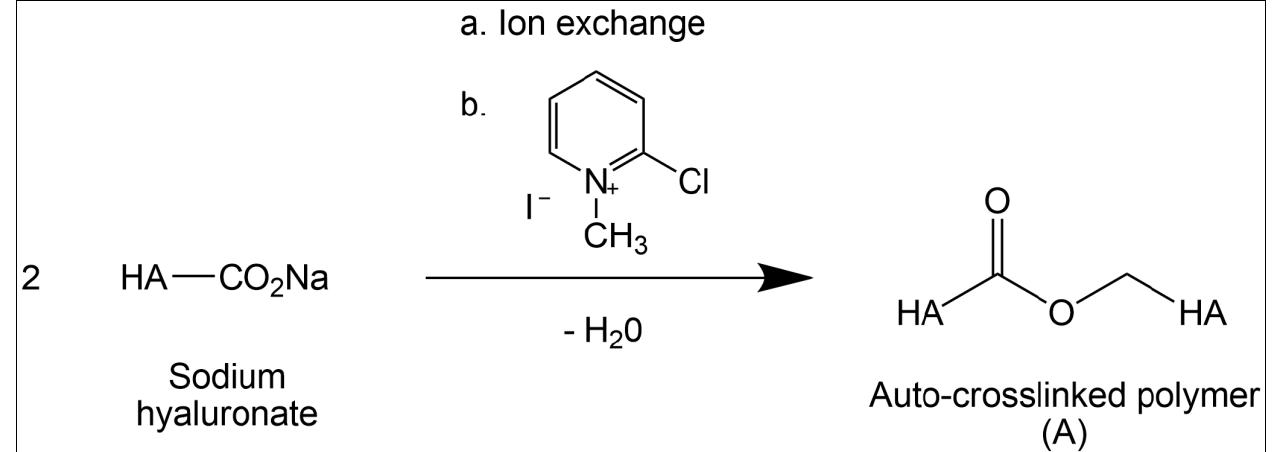
Figure 2. Synthesis of hyaluronic acid auto-crosslinked polymer gel (Hyalobarrier ® ).